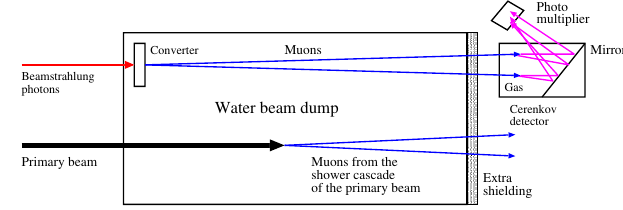
FIG. 28. (Color) Cerenkov beamstrahlung detector based on the conversion of high-energy beamstrahlung photons into muon pairs, that are the only charged particles penetrating the beam dump and can be detected by their emission of Cerenkov light in a gas detector. Note that the high-energy muons generated by the primary beam are predominantly forward peaked and miss the Cerenkov